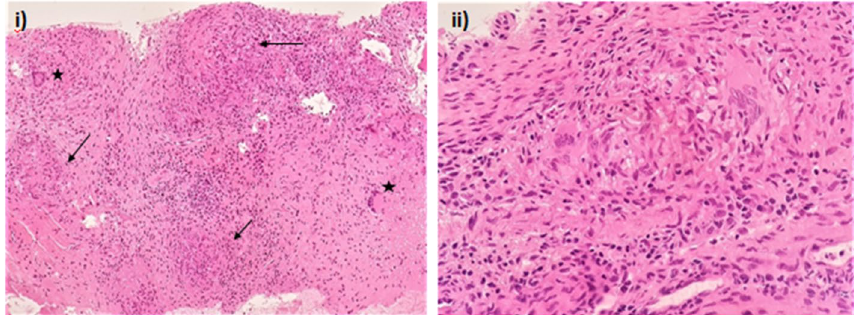
Fig. 2 i Multiple necrotizing epithelioid cell granulomas (arrows) along with langerhans giant cells (black asterisks) (H and E, 20X) ii High power view of epithelioid cell granuloma along with giant cells (H and E,